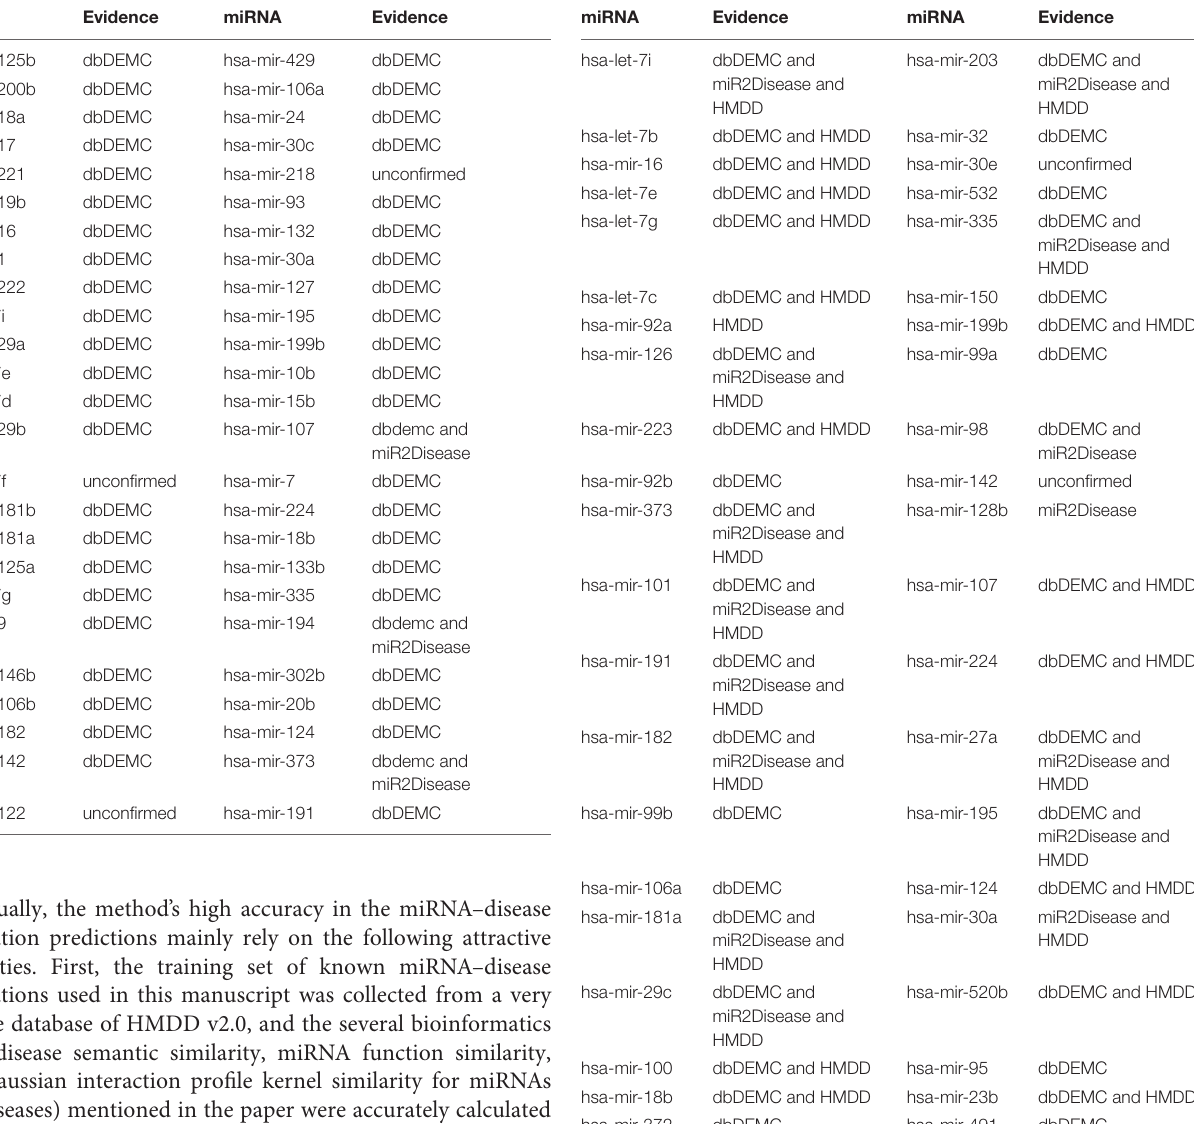
TABLE 2 | The implementation of BRWRMHMDA to prioritize candidate miRNAs for breast neoplasms based on experimentally confined miRNA–disease associations collected from HMDD v1.0 and 48 of the first 50 predicted miRNAs were